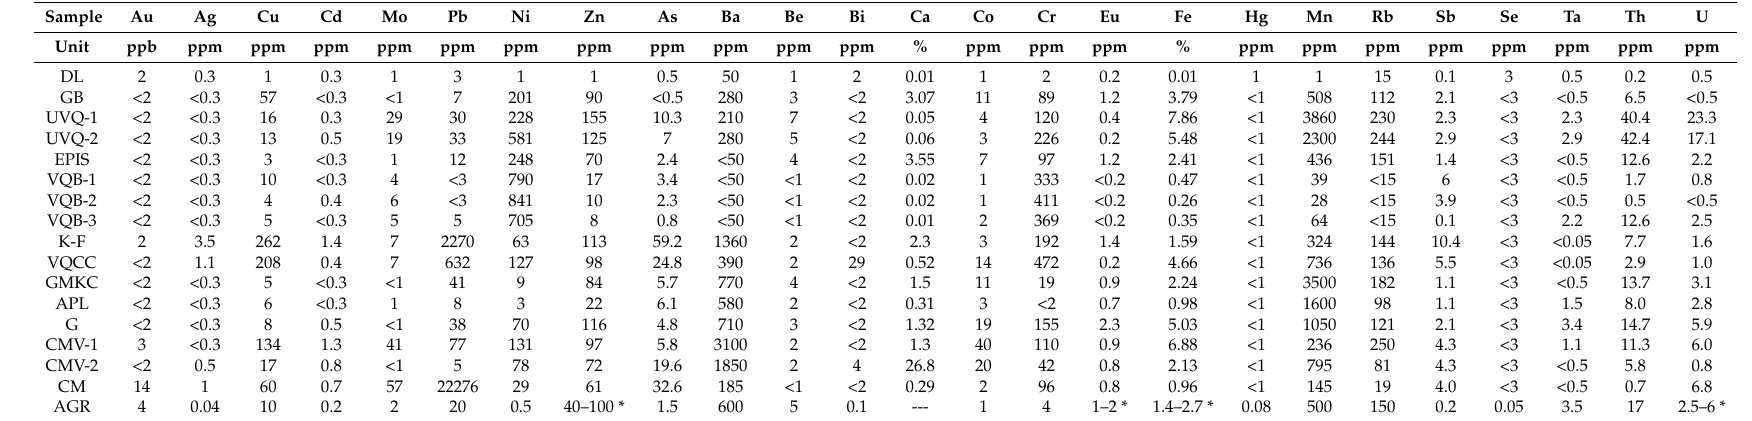
Table 1. Geochemistry of igneous rocks and